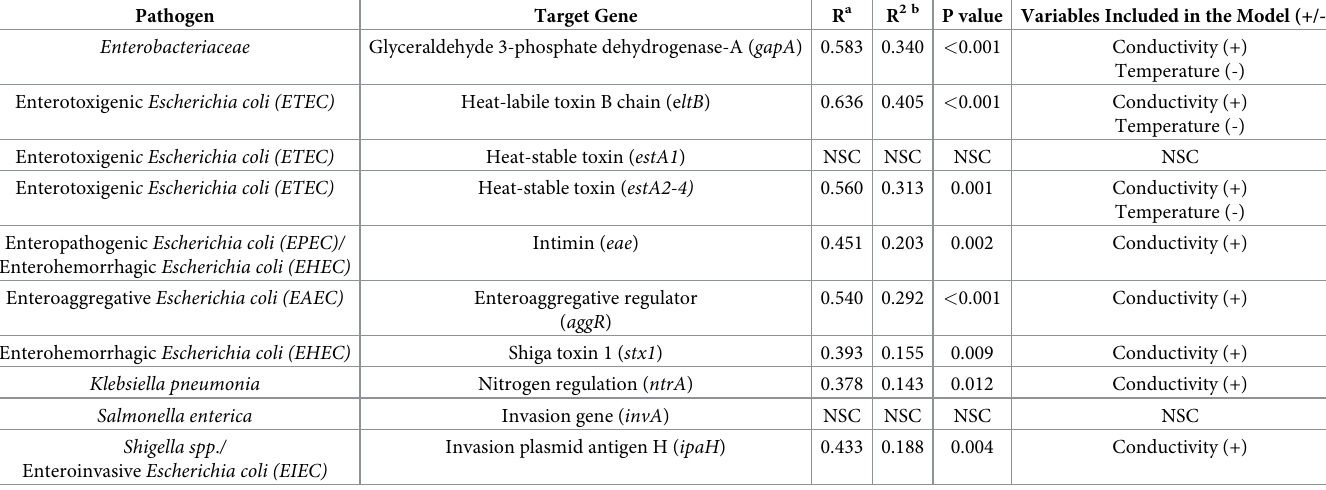
Table 2. Stepwise linear regression results for all pathogens analyzed in water samples from La Paz River basin.